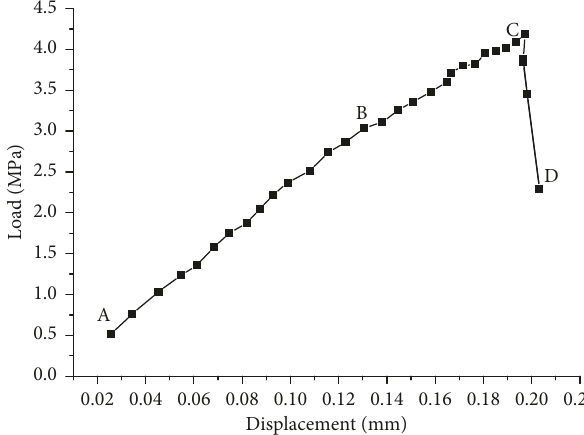
Figure 15: The load-displacement curve for specimen CON080 under dynamic tension